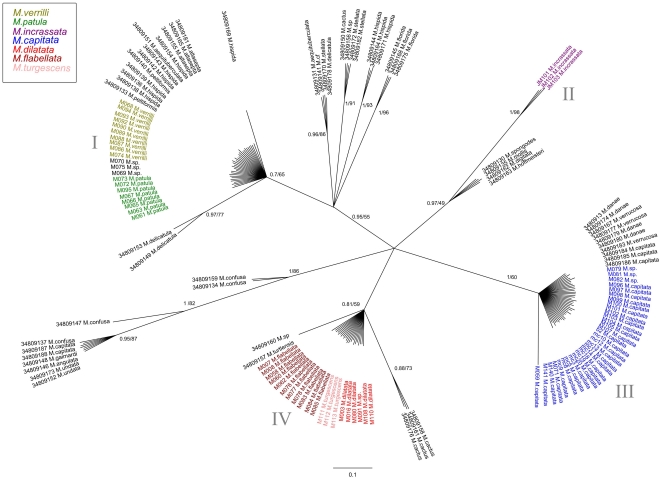
Bayesian inference tree of the mitochondrial control region for Hawaiian specimens and data from van Oppen et al.[12].Confidence values are BI/ML, and species are color coded by morphospecies identification.